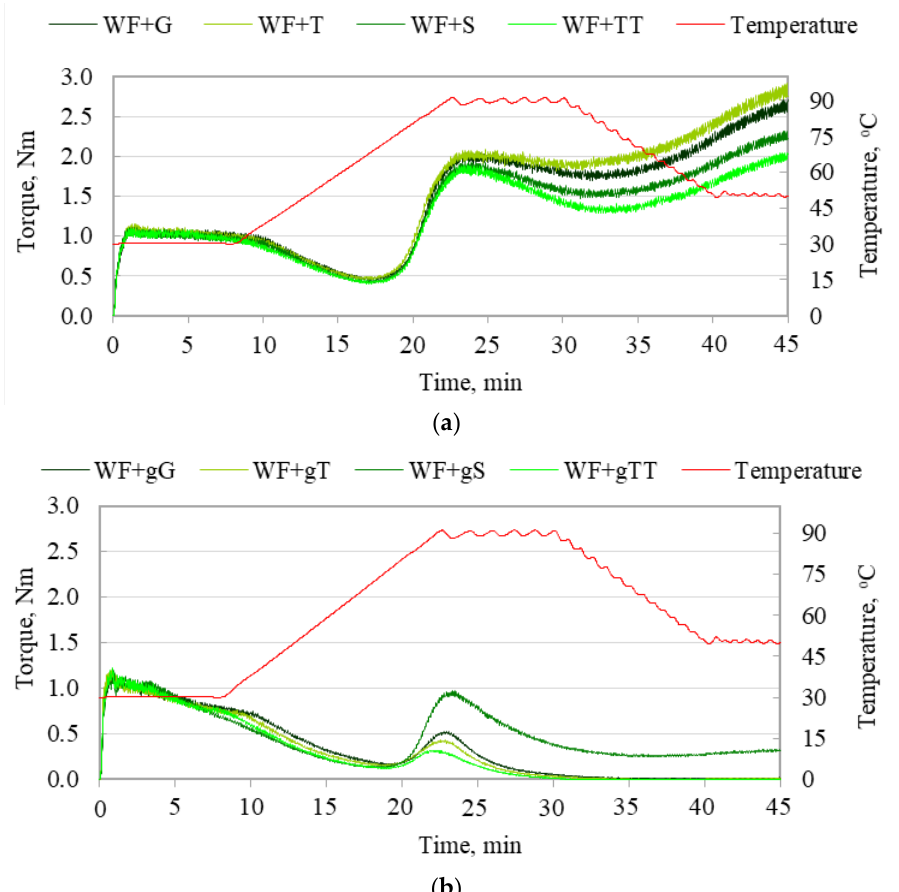
Figure 4. Mixolab curves of the white wheat flour (WF) supplemented with 15% wholemeal flours obtained by milling ( a ) raw (G, T, S and TT) and ( b ) germinated grains (gG, gT, gS and gTT).